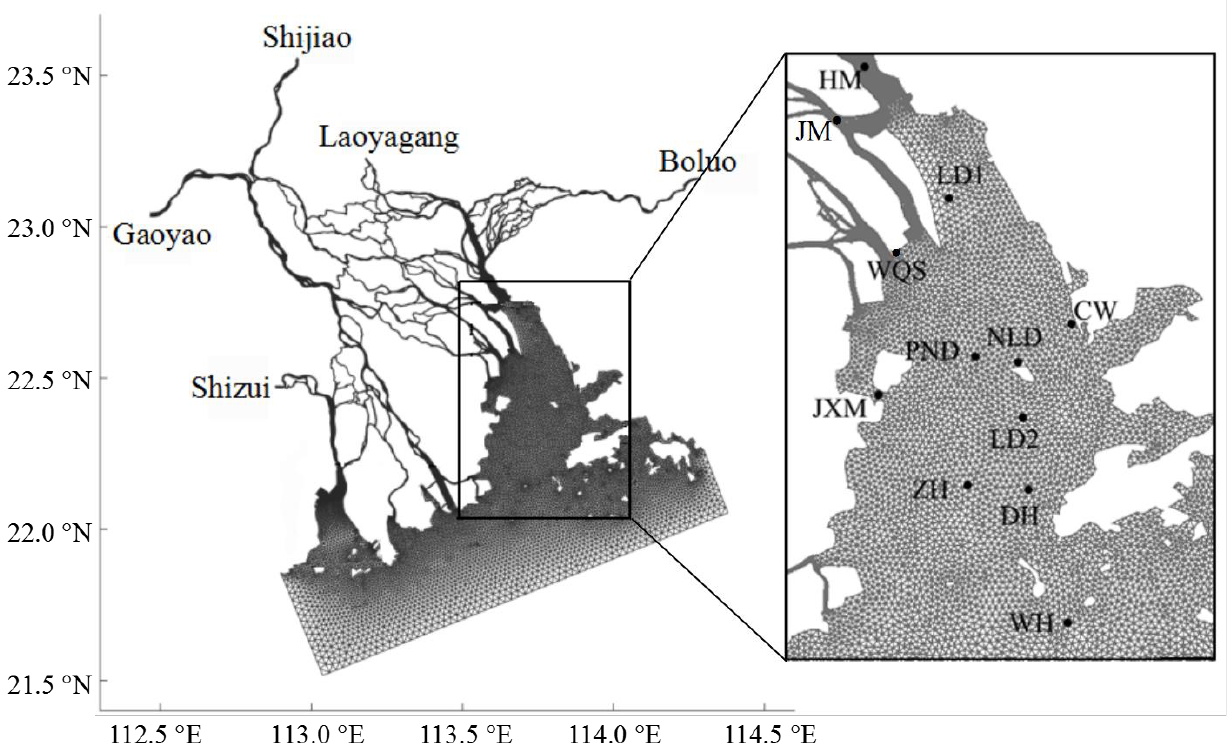
Figure 2. The unstructured triangle mesh with the data locations shown in the right panel.